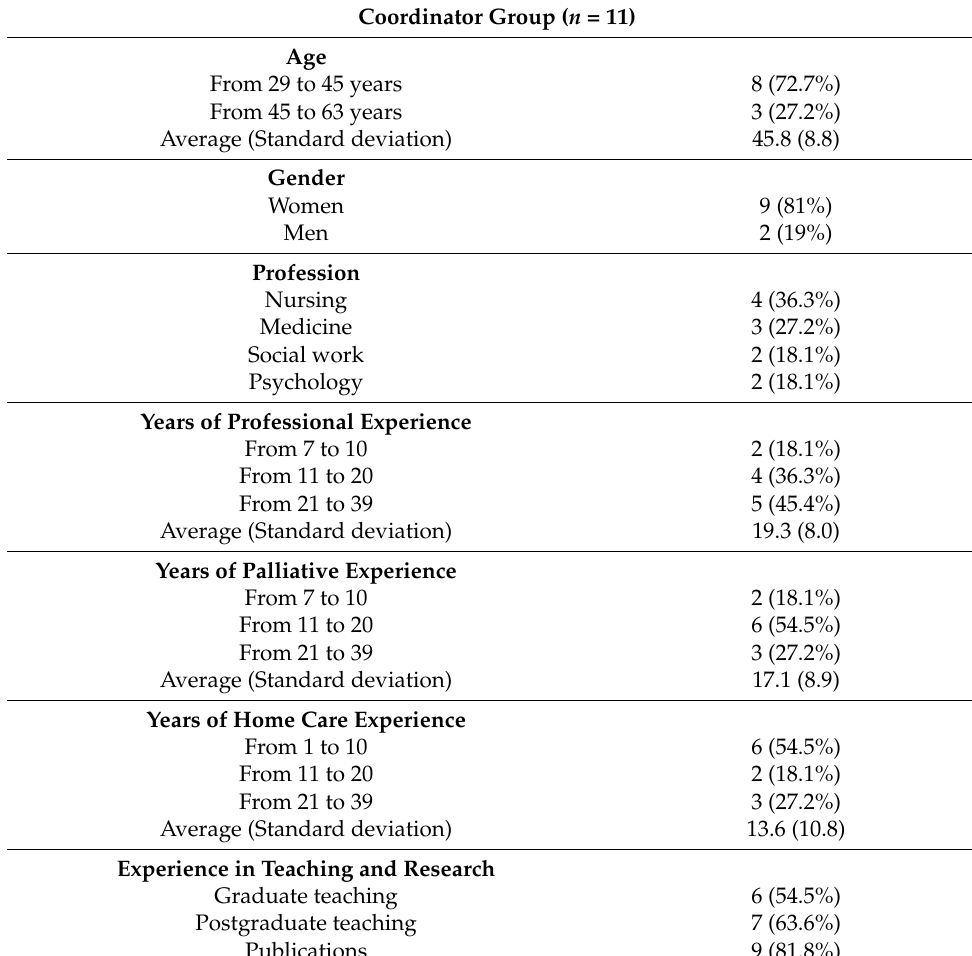
Table 2. Characteristics of the coordinating